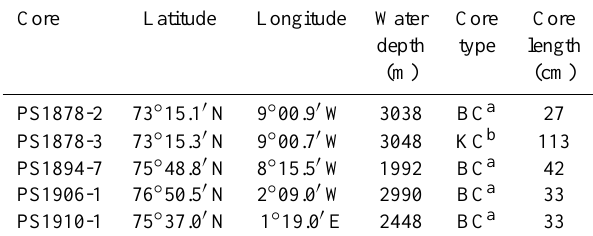
Table 1. Cores used in the study. Table 2. AMS 14 C measurements and their calibrated ages for the cores used in the study (BP – before